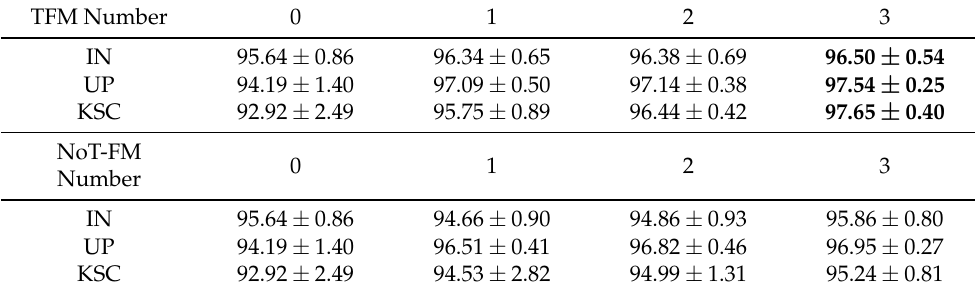
Table 4. Classification performance of the three data sets, considering the TFM number in the backbone lightweight framework ranging from 0 to 3 and comparison with a fusion mechanism of NoT-FM in terms of the OA (%). The best results are highlighted in bold font. TFM Number